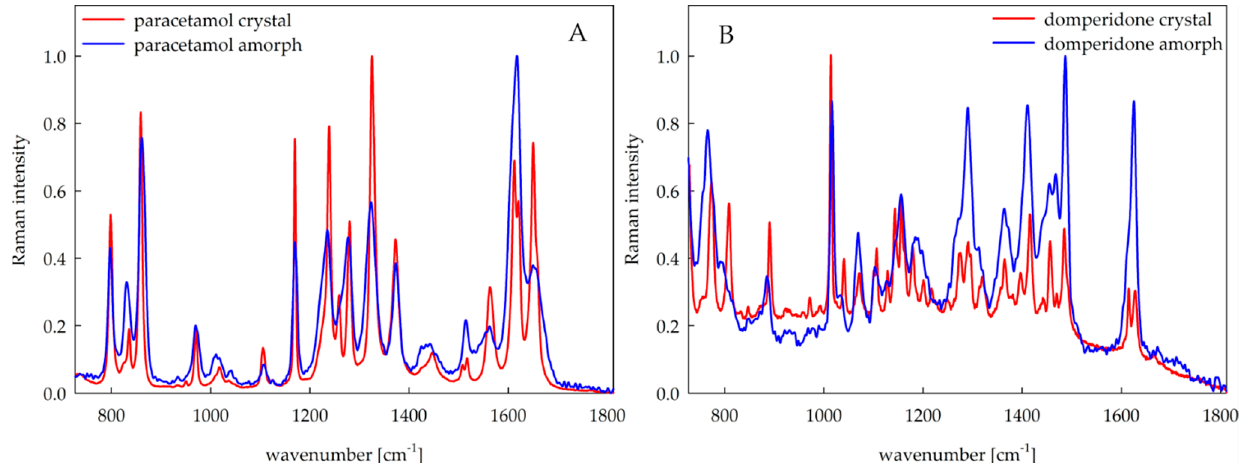
Figure 8. Reference Raman spectra of paracetamol in crystalline and amorphous form ( A ) and domperidone in crystalline and amorphous form ( B ).